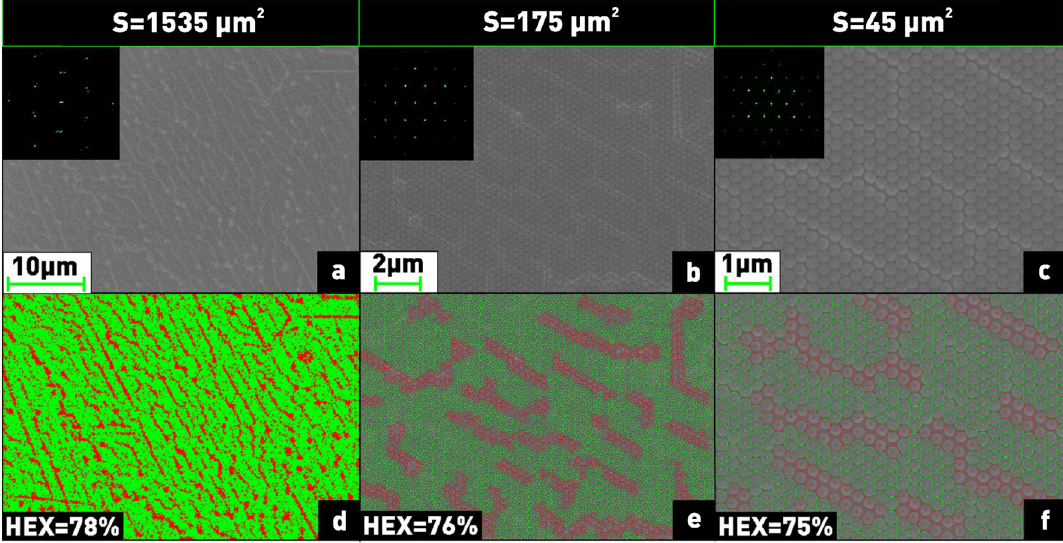
Figure 8. Qualitative and quantitative analysis of the hexagonal lattice on different substrate areas ( a–c ) using Fourier transform and HEXI